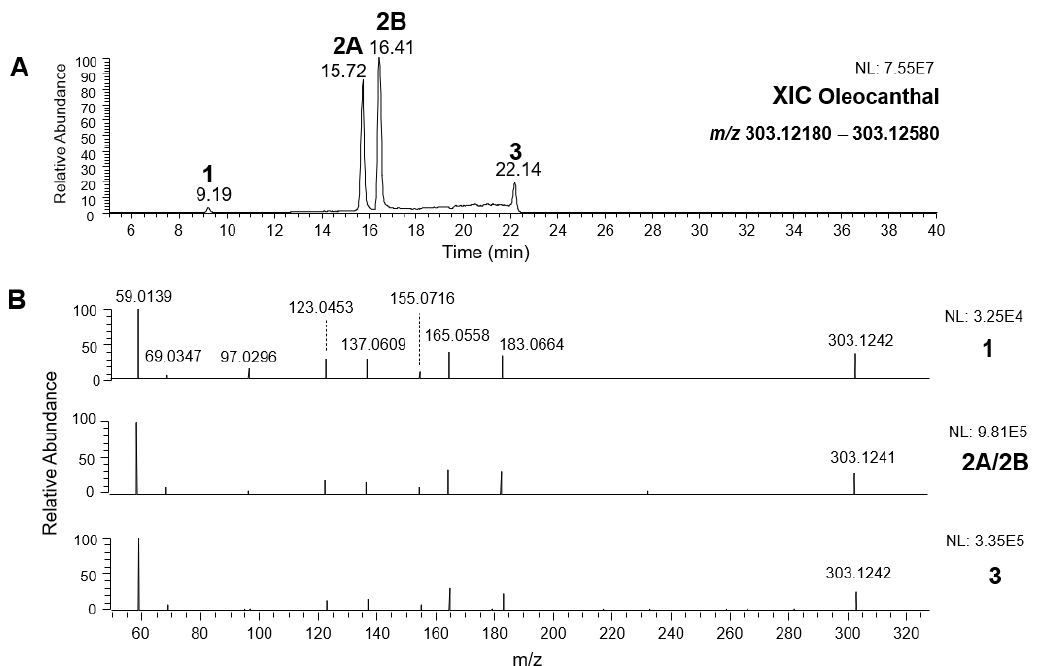
Figure 2. ( A ) Extracted Ion Current (XIC) chromatogram referred to monoisotopic deprotonated OLEO ([M ‐ H] ‐ , m / z 303.1238) obtained after the RPLC ‐ ESI( ‐ ) ‐ FTMS analysis of an EVOO extract. ( B ) HCD ‐ FTMS/MS spectra averaged under the main chromatographic peaks detected in the XIC trace. See Figures 4 and S1 for structures hypothesized for each product ion. To avoid redundancy, m / z labels for product ions, identical in all cases, were reported only in the first spectrum. NL = Normalization Level